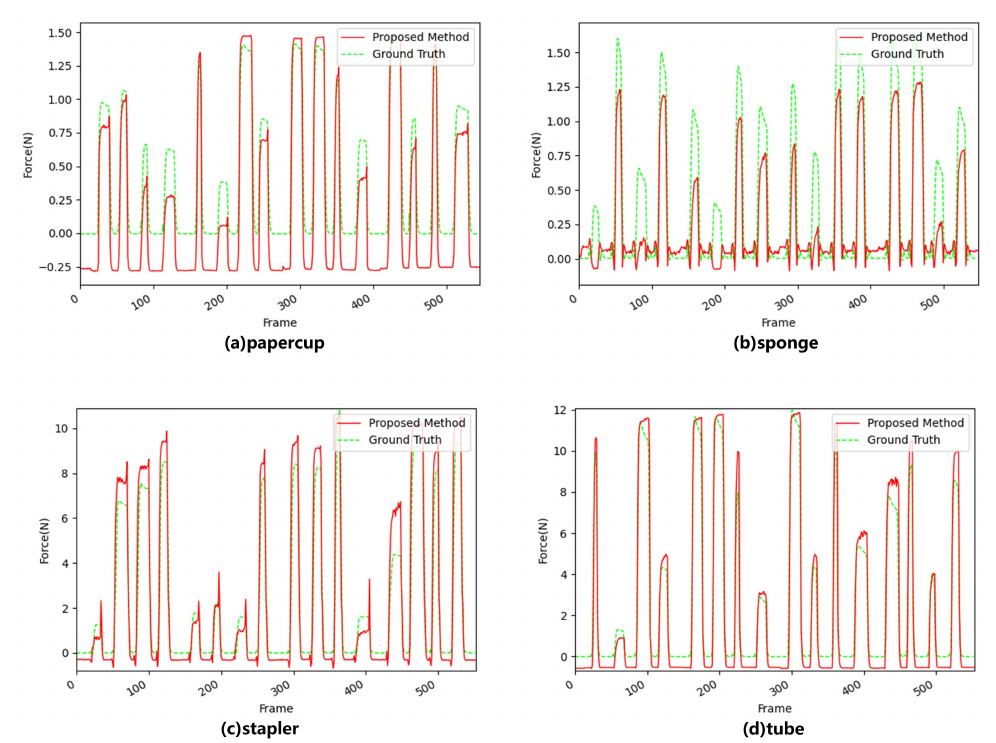
Figure 9. Performance results of the LRCNN, where red is the predicted value of the proposed method and green is the ground truth.